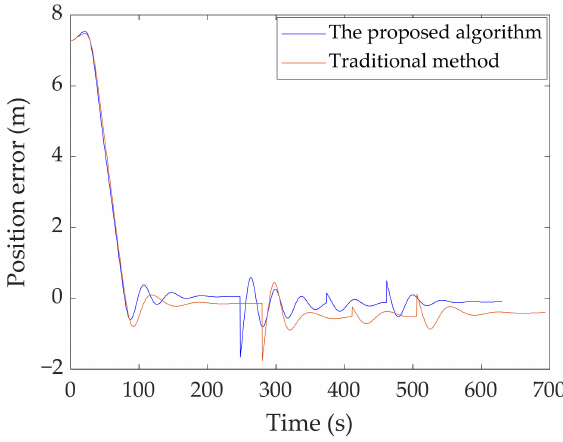
Figure 17. Position error for the path tracking in the environment with